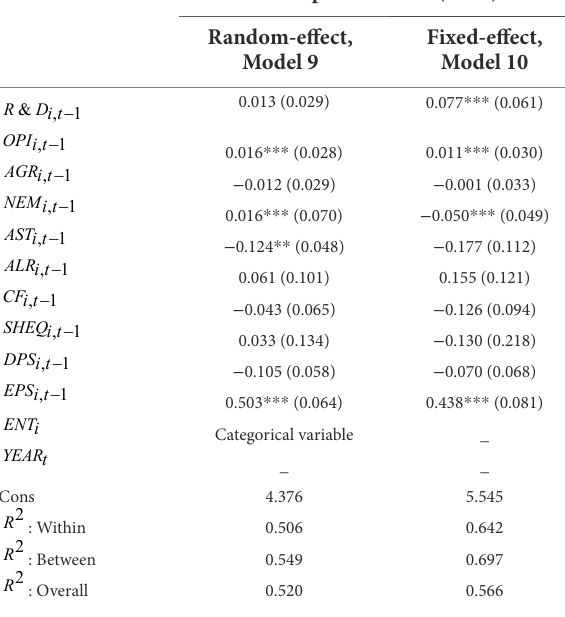
TABLE 7 Estimation results for the 25% smallest